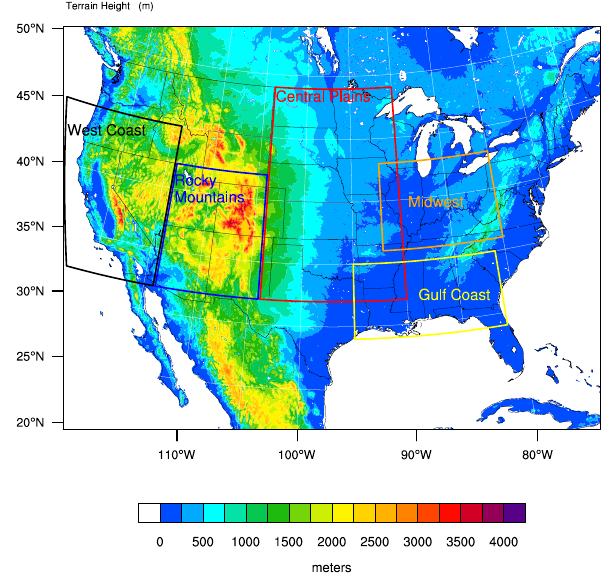
Fig. 1. Domain and terrain height (m) of the model simulation. Marked regions are used in the radar reflectivity evaluation and the chemistry